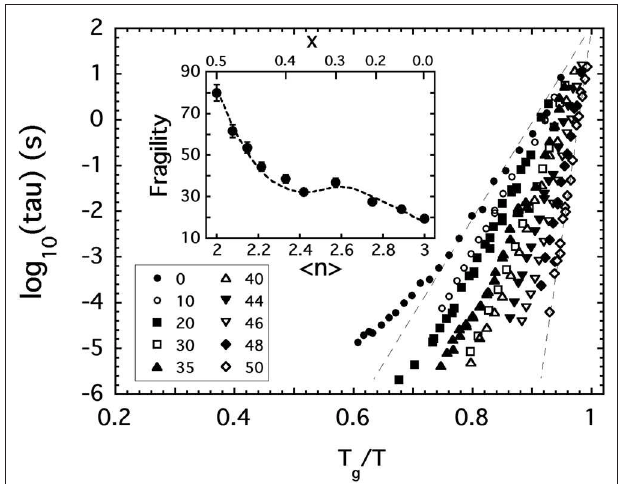
FIGURE 2 | The structural relaxation time (tau) of various [Na 2 O] x [P 2 O 5 ] 1 − x glass melts plotted against inverse temperature scaled to the glass transition temperature where tau = 100s. Key shows values of x expressed as a mole % of Na 2 O. Inset shows how the fragility index of these melts depends on h n i , the average BO per phosphate unit.